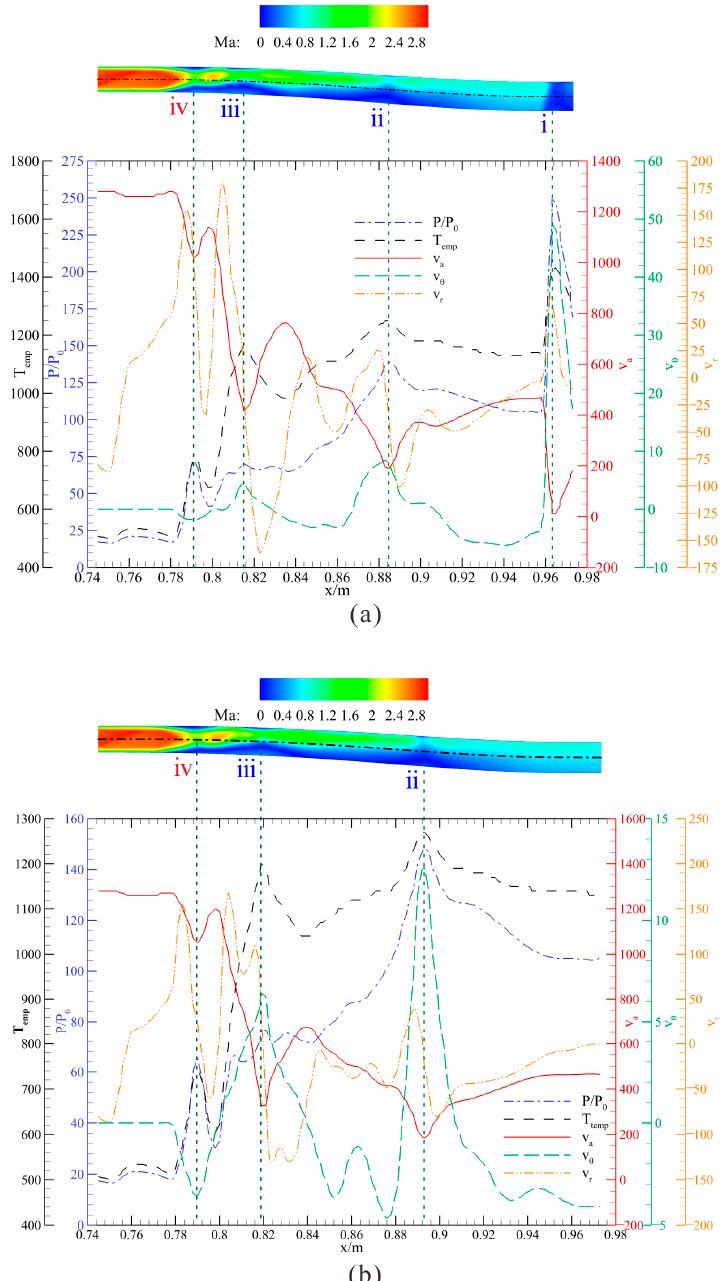
Figure 10. Aerodynamic parameter distribution curves of the sectional centerlines along the axial direction. ( a ) θ = 135°. ( b ) θ = 180°.